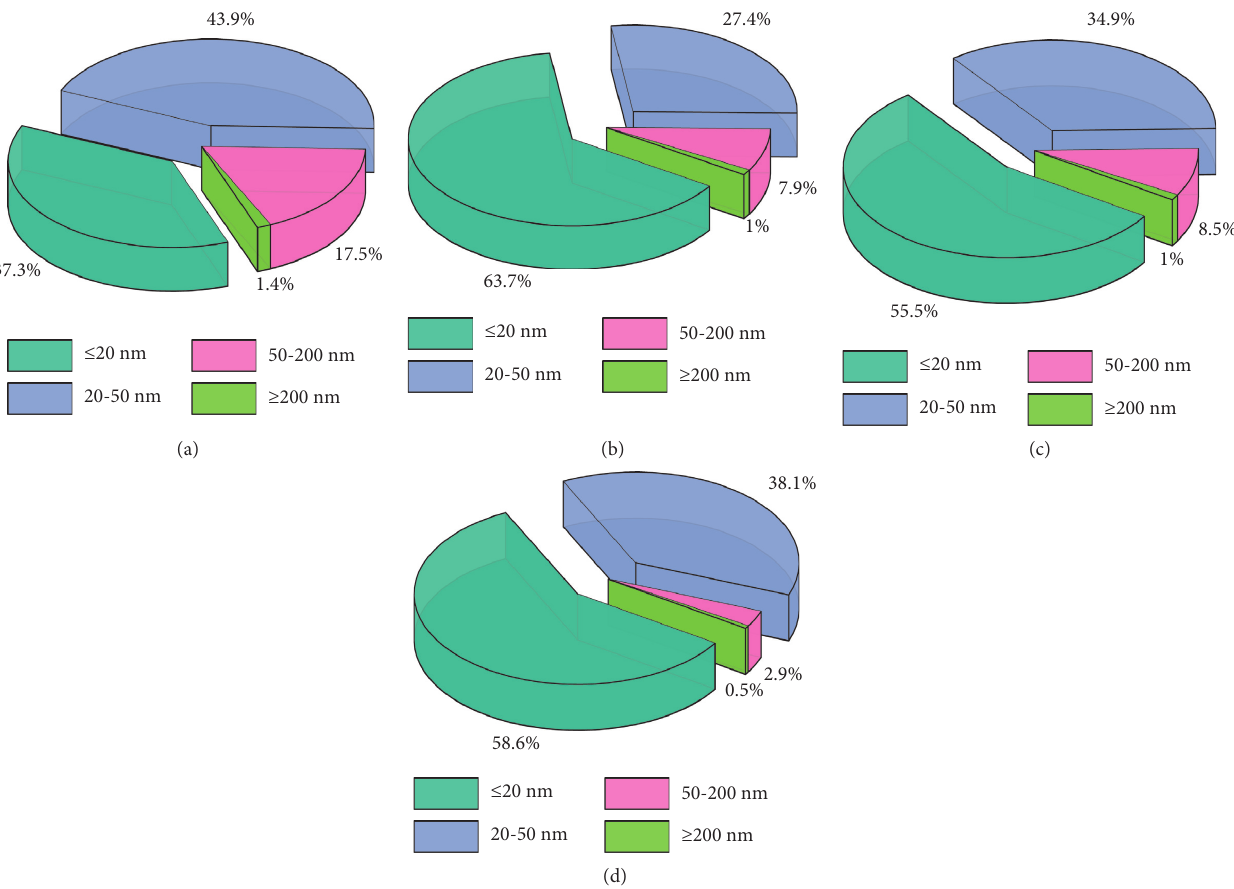
Figure 9: Proportion of pore sizes for each concrete group. (a) OPC (NaCl-0%). (b) CFA-40 (NaCl-0%). (c) OPC (NaCl-3.5%). (d) CFA-40